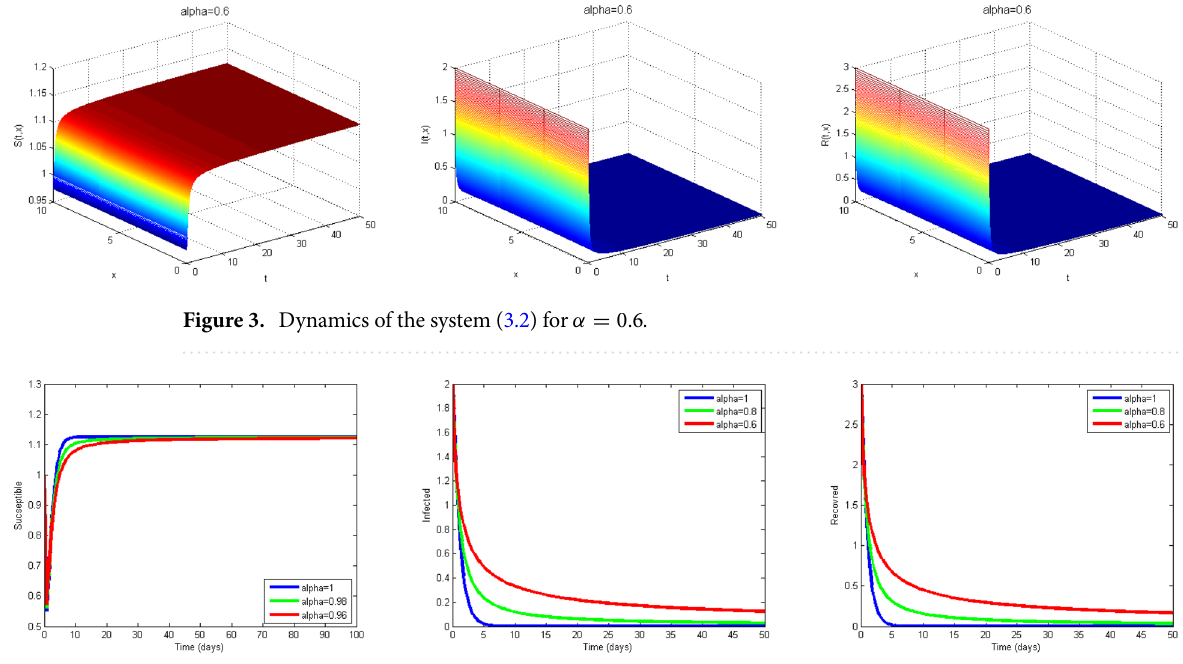
Figure 4. Dynamics of the system (3.2) for x fixed and for α = 0.6, 0.8, 1 in the case where R 0 = 0.1372 < 1 .